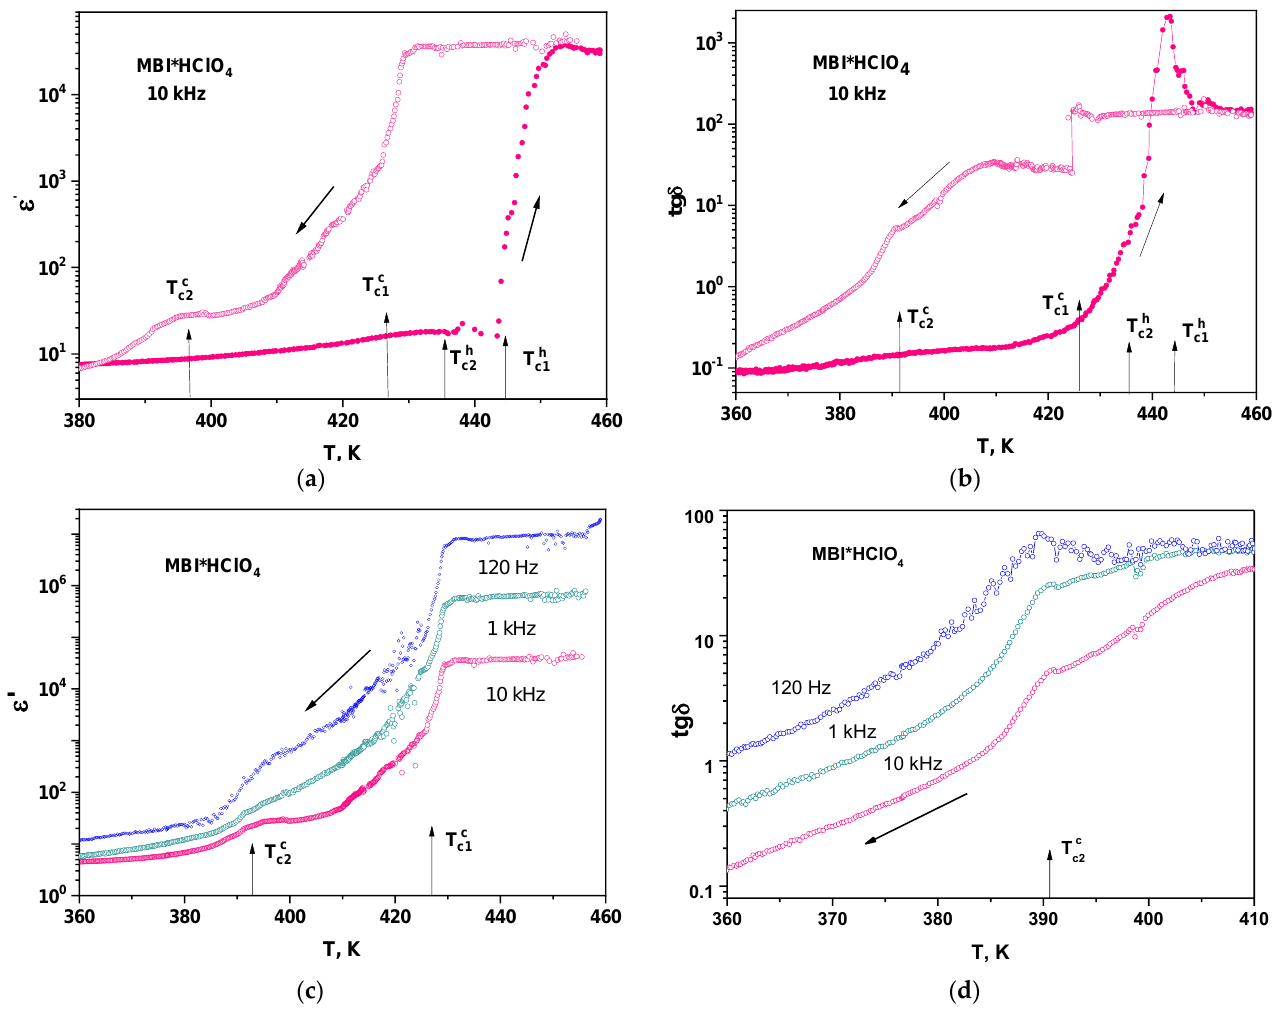
Figure 11. Temperature dependence of dielectric constant ε (cid:48) ( a ) and dielectric losses tg δ ( b ) in semi- logarithmic scales in MBI · HClO 4 crystal during the heating-cooling cycle at frequency of 10 kHz. Temperature dependence of dielectric constant ( c ) and tg δ ( d ) for cooling at frequencies f of 120 Hz, 1 kHz, and 10 kHz.